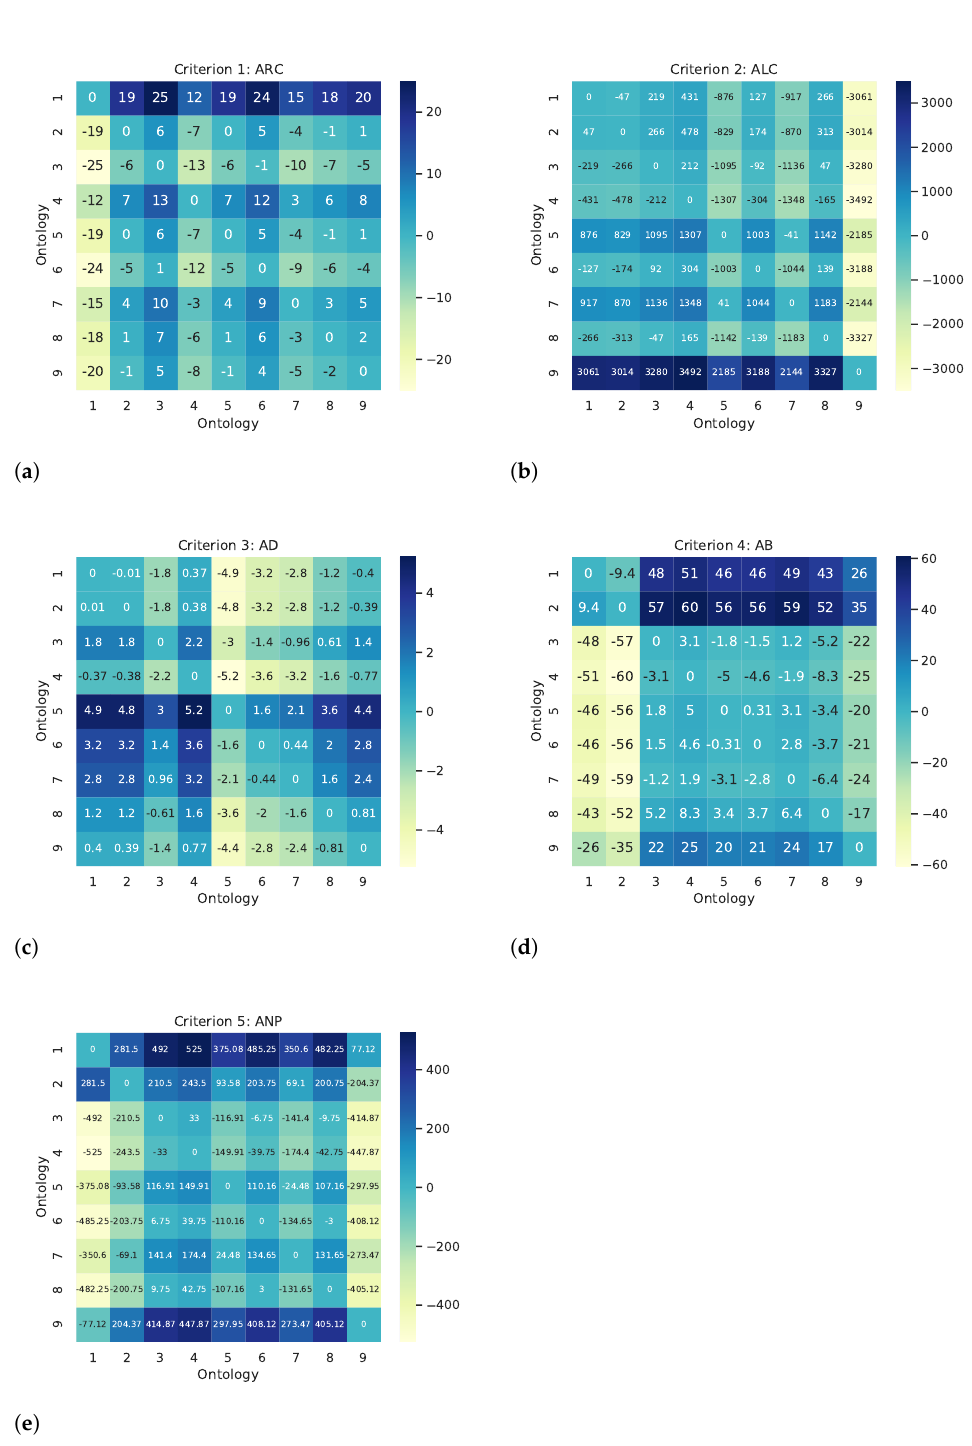
Figure 2. Differences in quantitative criterion performance for all alternative pairs. ( a ) Difference in criterion performance for ARC. ( b ) Difference in criterion performance for ALC. ( c ) Difference in criterion performance for AD. ( d ) Difference in criterion performance for AB. ( e ) Difference in criterion performance for ANP After analyzing the differences and distances between the criteria for all alternatives, the discordance relations are determined. For comparing each alternative pair, x and y , the comparison between their criteria performances are partitioned into one of three discor- dance sets: high discordance Q + ( x , y ) , medium discordance Q 0 ( x , y ) , or low